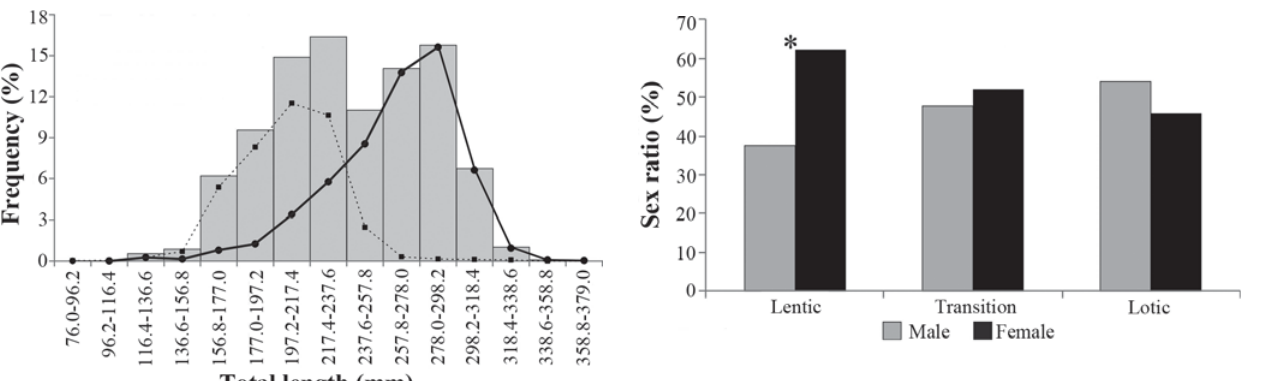
Fig. 4. Sex ratio of A. pantaneiro captured in different hydrological conditions in the upper Uruguay River between October 2000 and August 2006 (* indicates a statistically significant difference at the 5% level -